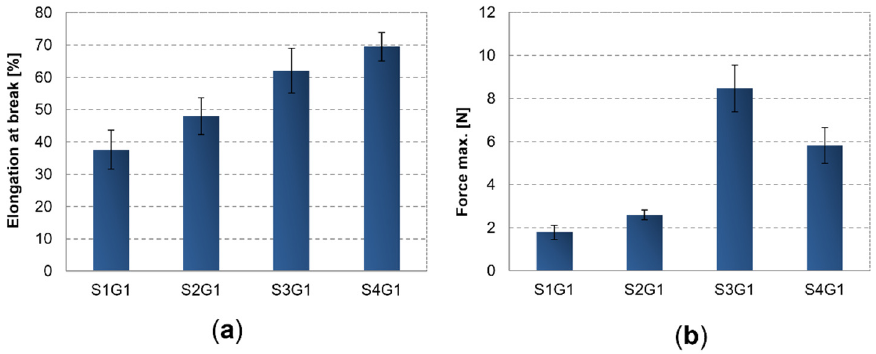
Figure 7. Elongation at break ( a ) and maximum force ( b ) in static stretching test of hydrogels ( n = 5).